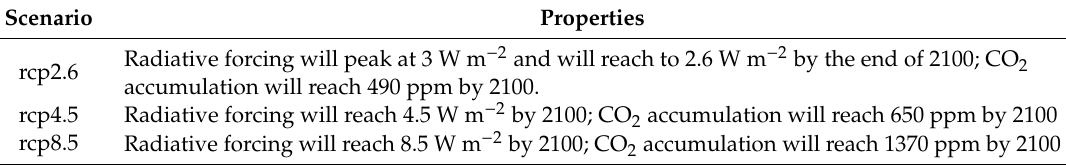
Table 2. Properties of the applied scenarios authorized by the Intergovernmental Panel on Climate Change (IPCC) [9].